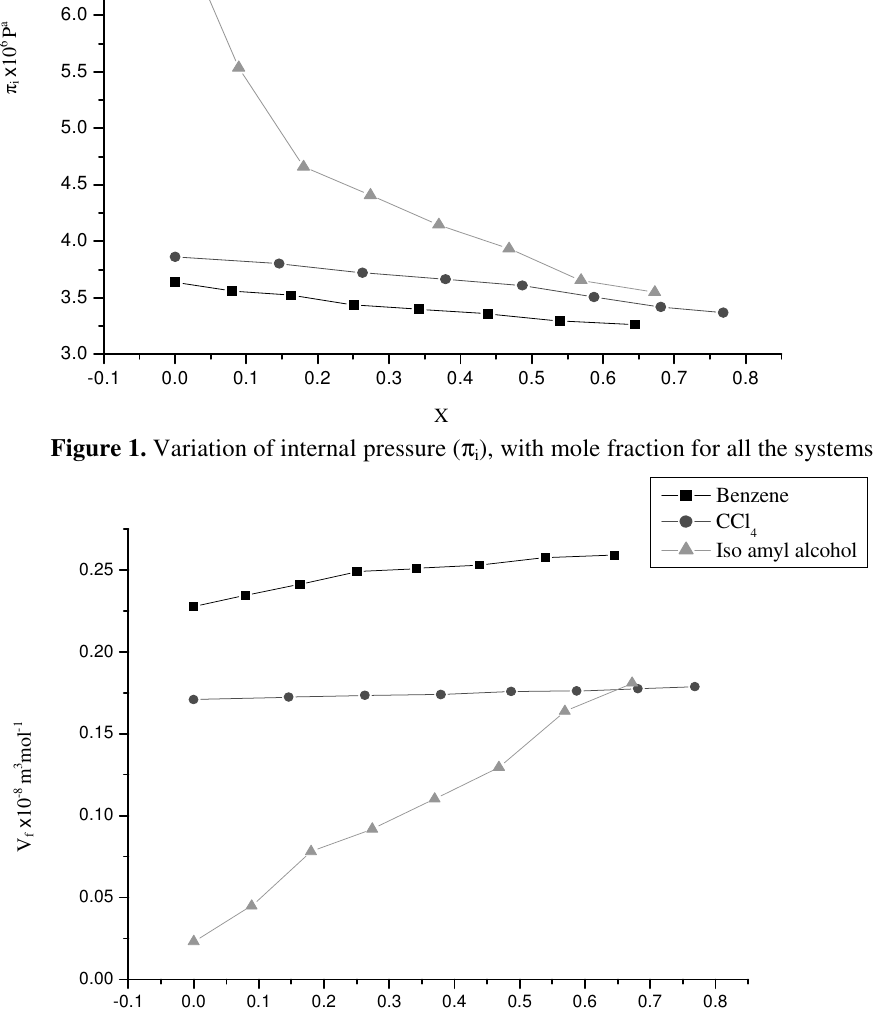
), with mole fraction for all the f